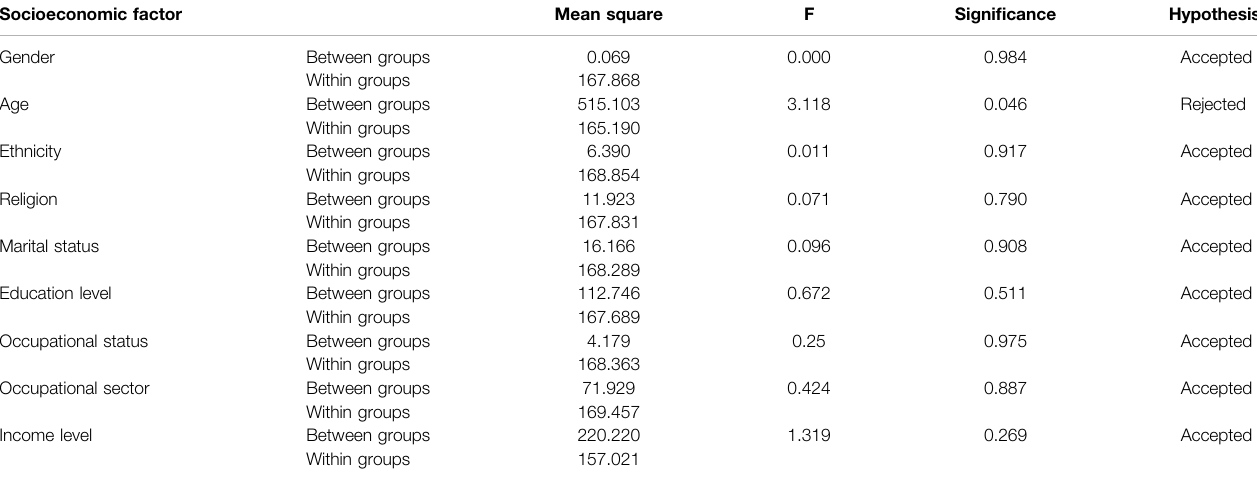
TABLE 9 | ANOVA results for daily travel cost with sociodemographic background. Socioeconomic factor